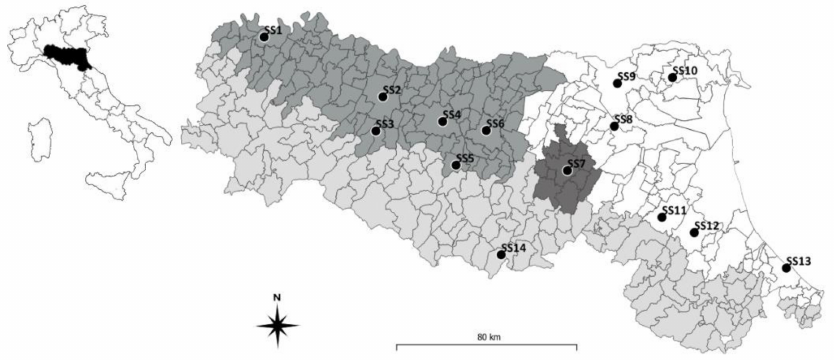
Figure 1. Study area and sampling sites. In light grey: Apennine mountains and hill area; in dark grey: west plain area; in white: east plain area; in black: the agglomeration area (Bologna city) (www.arpae.it) accessed on 1